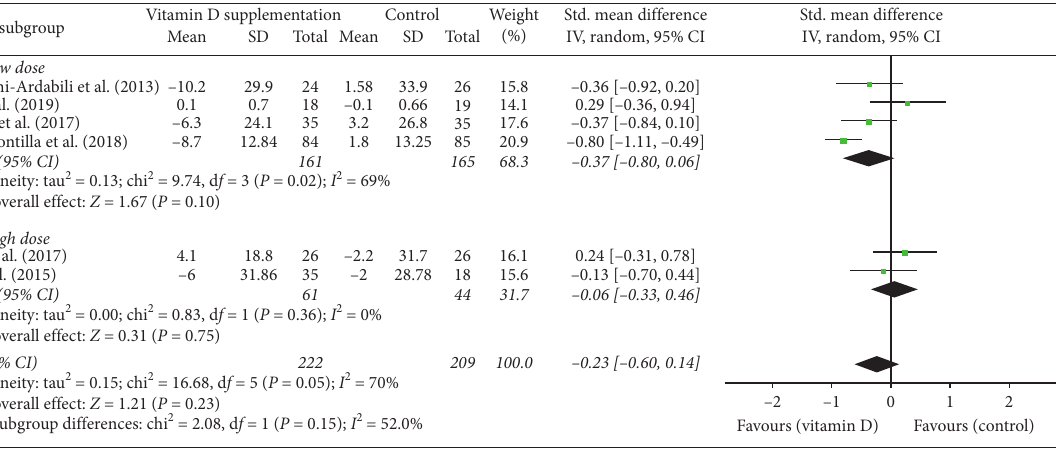
Figure 6: (a) Forest plot of total-C level in experimental and placebo groups. (b) Forest plot of LDL-C level in experimental and placebo groups. (c) Forest plot of VLDL-C level in experimental and placebo groups. (d) Forest plot of HDL-C level in experimental and placebo groups. (e) Forest plot of triglycerides in experimental and placebo groups. (f) Forest Plot of triglycerides in women with PCOS who have vitamin D deficiency or insufficiency. (g) Forest plot of total-C in women with PCOS who have vitamin D deficiency or insufficiency. (h) Forest plot of triglycerides in women PCOS supplemented by day, week, two weeks, and 20 days. (i) Forest plot of total-C in women with PCOS supplemented by day, week, and 20 days. (j) Forest plot of triglycerides in women with PCOS supplemented with a low or high dose. (k) Forest plot of total-C in women with PCOS supplemented with a low dose or high dose. (l) Forest plot of LDL-C in women with PCOS supplemented with a low dose or high